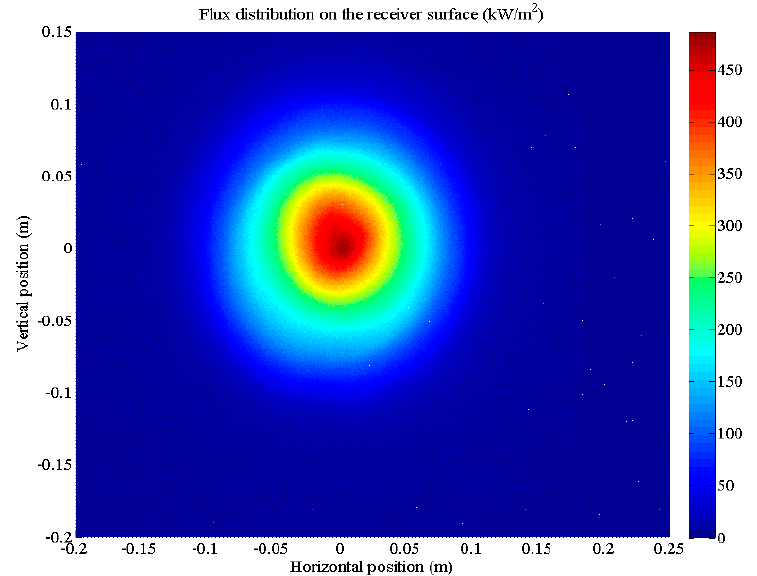
Figure 2. Energy flux distribution of 1–7 lamps with 100 A current when the mirrors were clean.